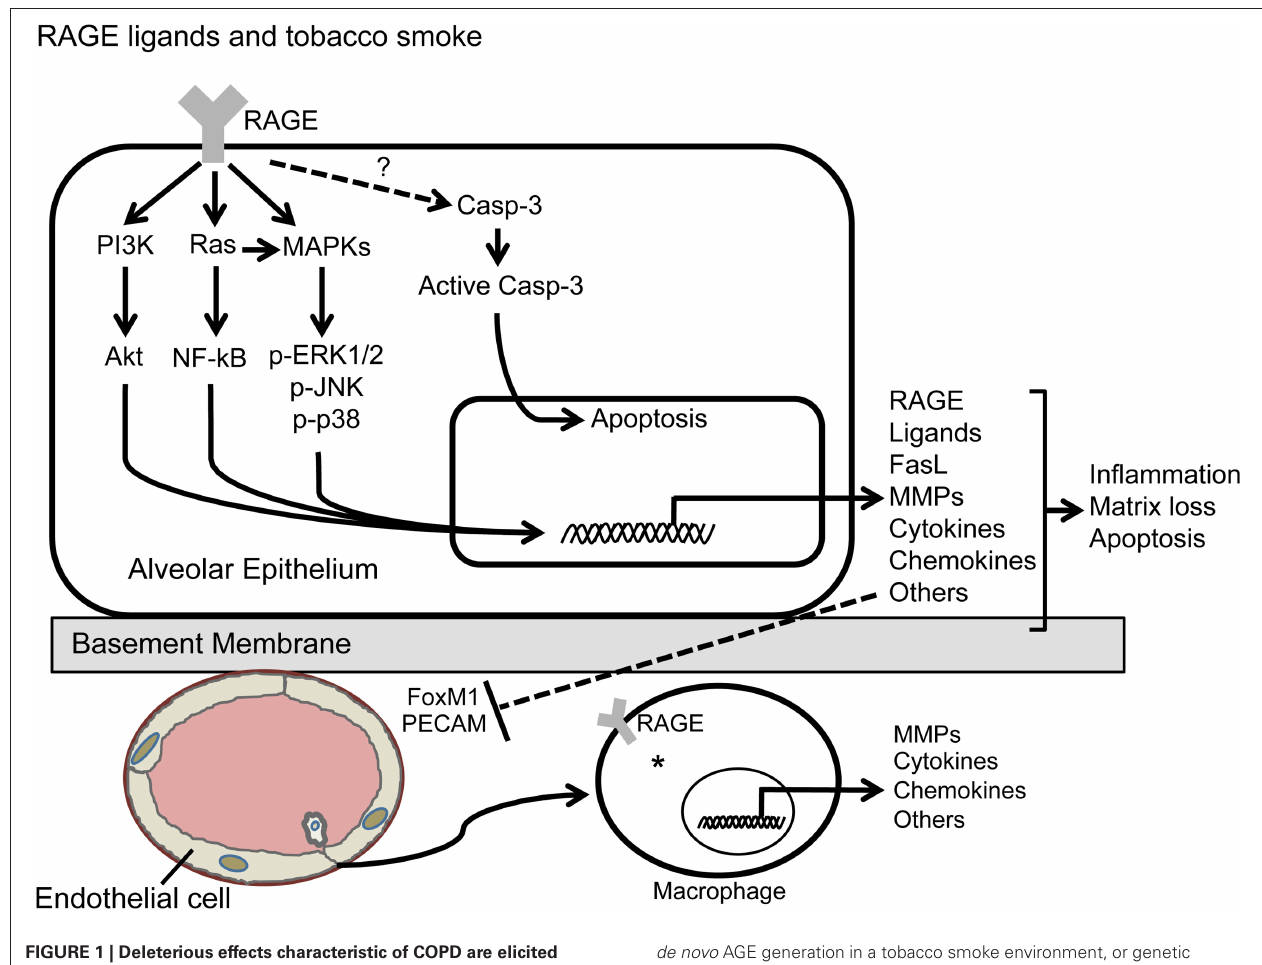
de novo AGE generation in a tobacco smoke environment, or genetic up-regulation of RAGE in the lungs of conditional bi-transgenic mice results in characteristics of COPD including inflammation, matrix destabilization, and